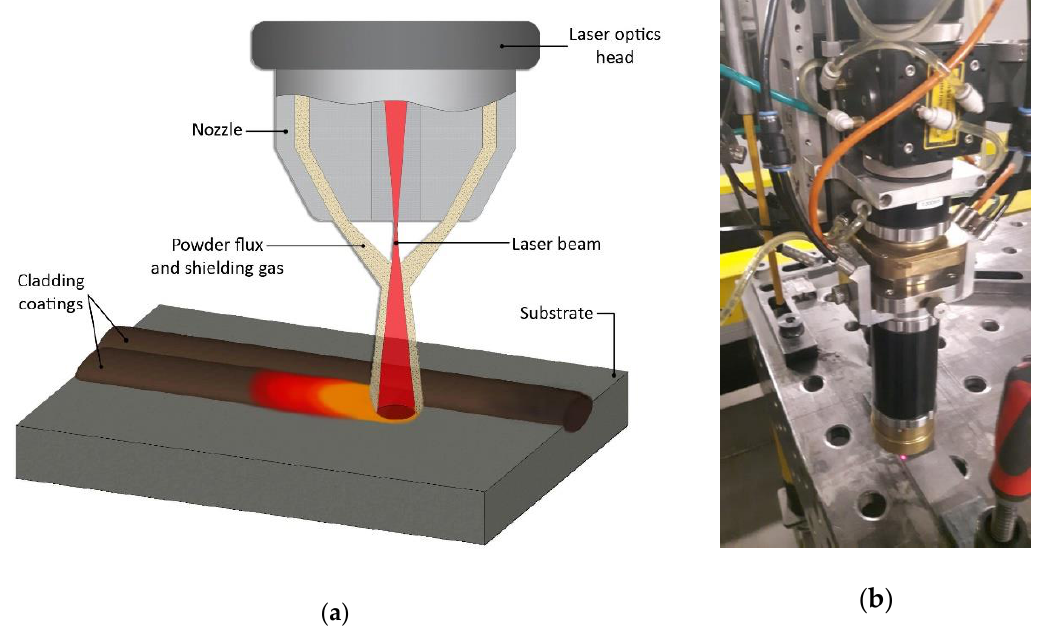
Figure 1. Cross-section diagram of the powder feeding head ( a ), picture of Laserline COAX head ( b ). The coatings were generated on flat substrates of 16Mo3 steel (EN 10216-2) with dimensions of 100 mm × 50 mm × 4 mm. It is chromium-molybdenum boiler steel, adapted to work at elevated temperatures, used in the construction of key elements of power boilers (including steam superheaters). The steel hardness is 155 ÷ 160 HV 10 , the structure is ferritic-pearlitic, with ferrite grains of 8 ÷ 12 µ m. The corresponding chemical composition of this steel is detailed in Table